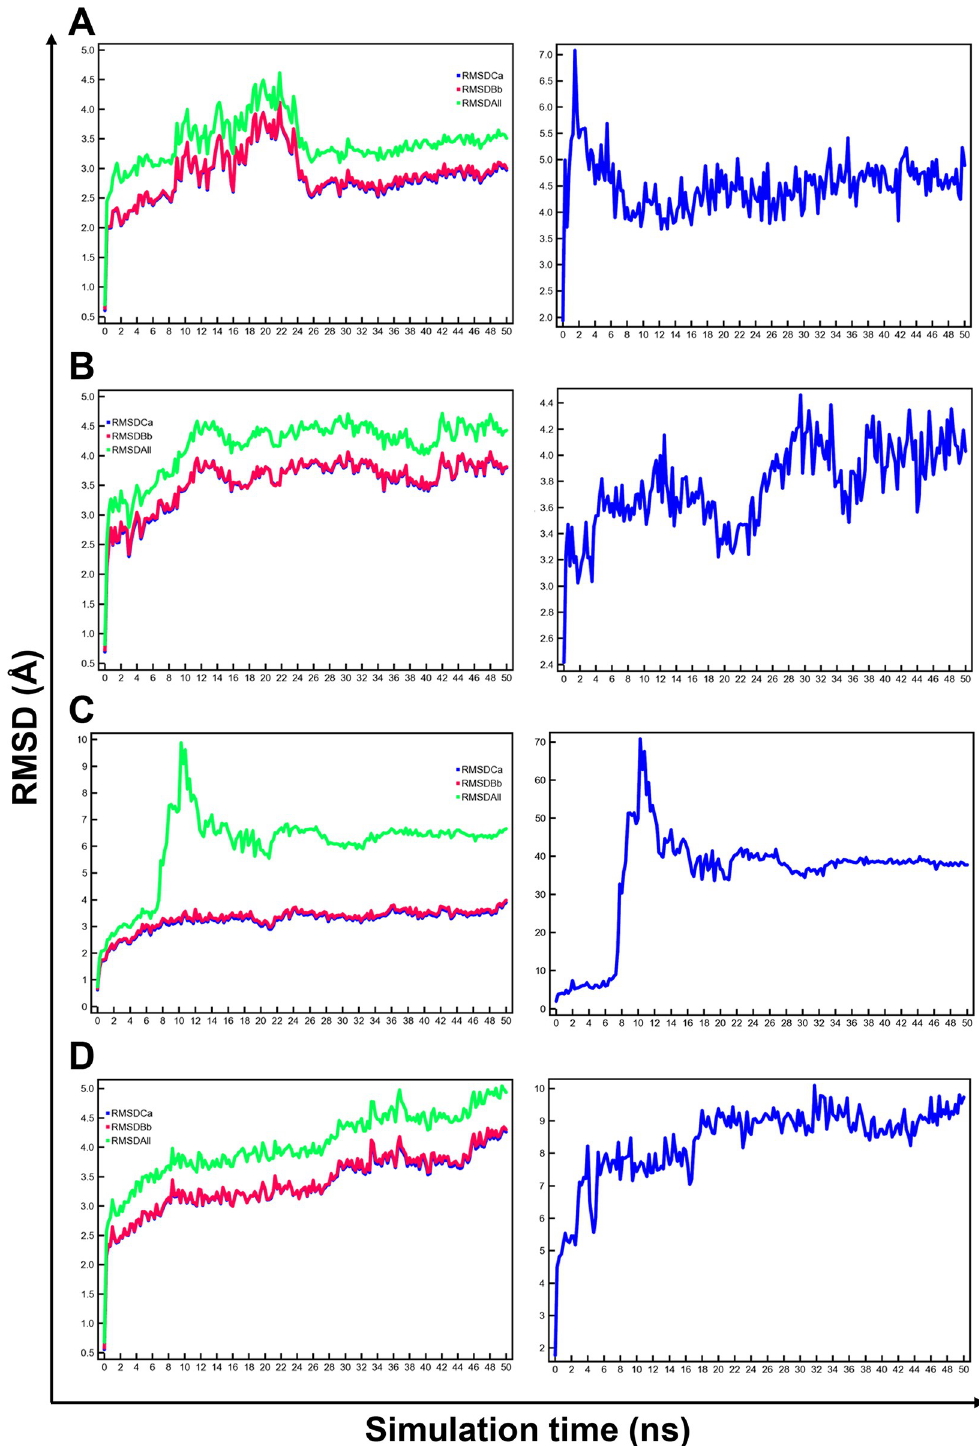
Fig 7. Stability assessment of two SBATs and two ASBTs docking with compound 9806452. (A) OF-CsSBAT, (B) IF-CsSBAT, (C) OF-HsASBT, and (D) IF-HsASBT. (Left panel) RMSD values of C α (RMSDCa in blue), backbone (RMSDBb in red), and all heavy atoms (RMSDAll in green) from each initial structure during 50 ns simulation time. (Right panel) The RMSD pattern of the compound within each complex.